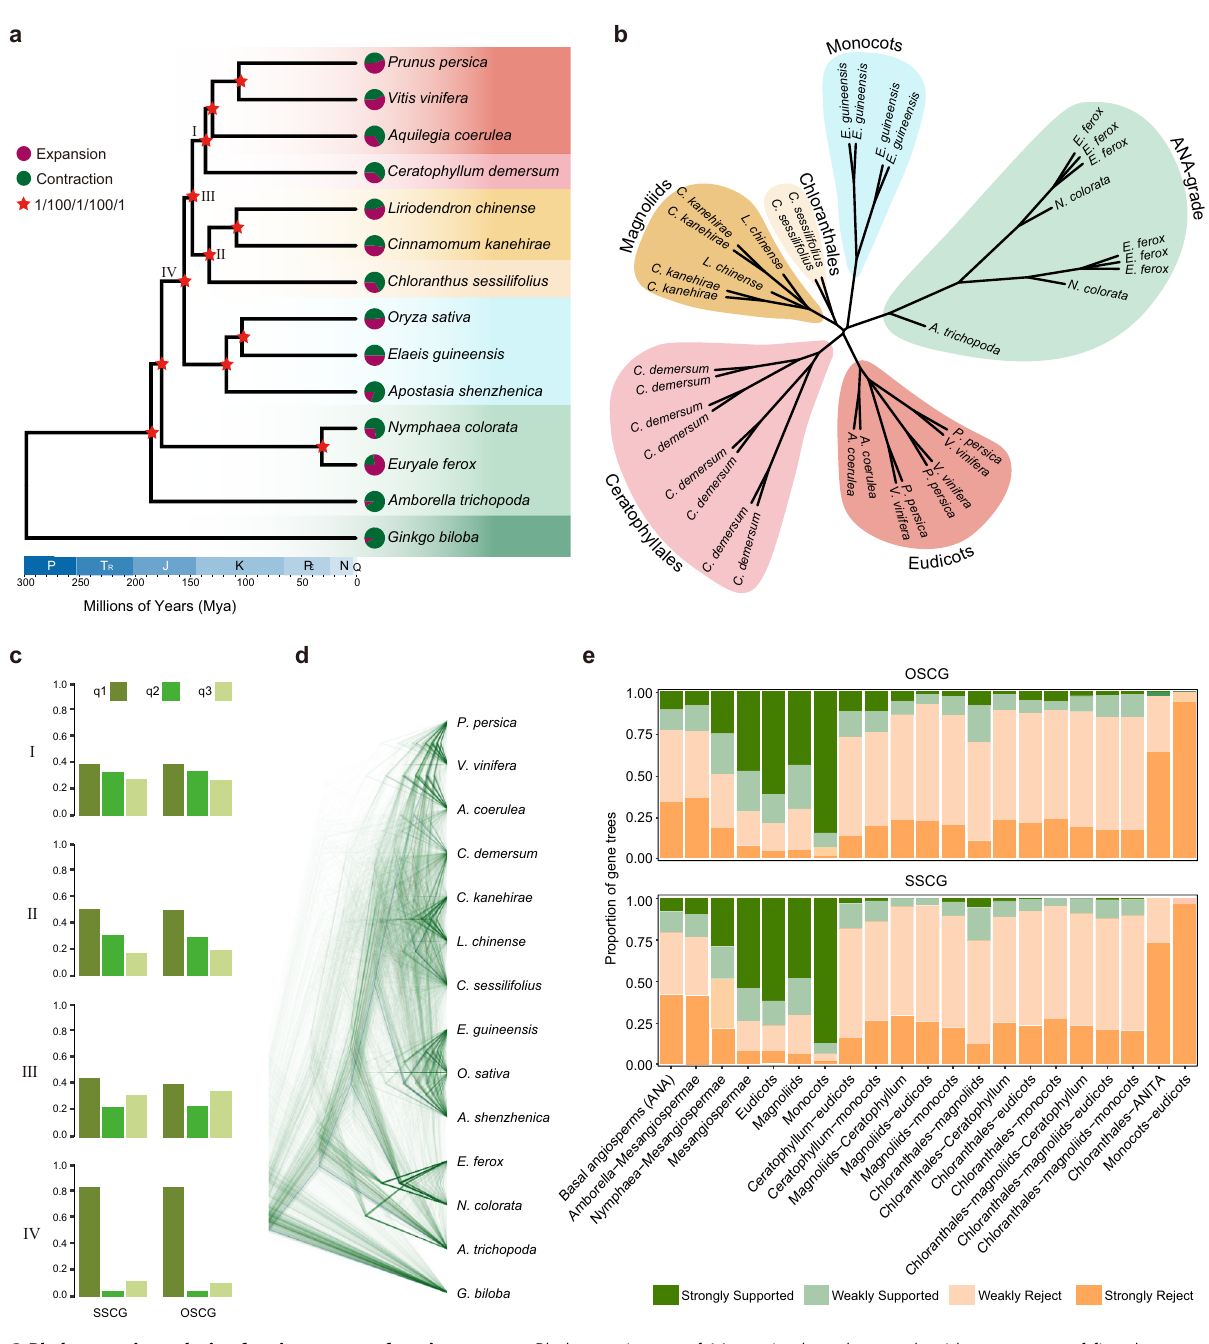
Fig. 3 Phylogenomic analysis of major groups of angiosperms. a Phylogenetic tree of 14 species based on nucleotide sequences of fi ve datasets. Estimated divergence times and the time scale are shown at the bottom. Bootstrap support (BS) values and posterior probabilities (PP) are indicated with a red asterisk for each internal branch (from left to right: multi-species coalescent-based (PP), concatenated-based (BS), multi-species coalescent-based (PP), concatenated-based (BS), and multi-species coalescent-based (PP), using SSCG, SSCG, OSCG, OSCG, and LCG datasets, respectively). The pie graph at the end of the terminal branches represents the proportion of gene families that underwent expansion (red) or contraction (green) when comparing with their most recent common ancestor. b Synteny-based phylogeny tree of the selected 11 species (see the detail in Supplementary Fig. 18). c The proportions of gene trees with different topologies. The focal internal branches are marked with I, II, III, and IV. q1, q2 and q3 indicate the quartet support for the three alternative topologies. d Superimposed ultrametric gene trees based on the SSCG dataset. e Gene tree compatibility. The proportion of gene trees for which focal splits are highly (or weakly) supported (or rejected) are shown in respective colors. Weakly rejected splits are those that are not in the tree but are compatible if low (<75%) support branches are contracted. Source data are provided as a Source Data fi le.